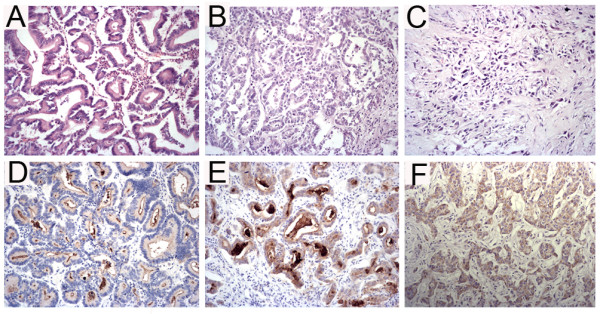
The expression and different subcellular localization of CD133 in CC. Among the CD133-positive cholangiocarcinoma, three staining patterns were identified: the well-differentiated tumors (A) were stained mostly on the apical membrane (D) or both membrane and cytoplasm (E) but the majority of moderately (B) and poorly differentiated (C) tumors were stained in the cytoplasm (F) or both membrane and cytoplasm, original magnification 400×. Also, in some cases, CD133-positive cellular debris was observed in the malignant glandular lumina (E).